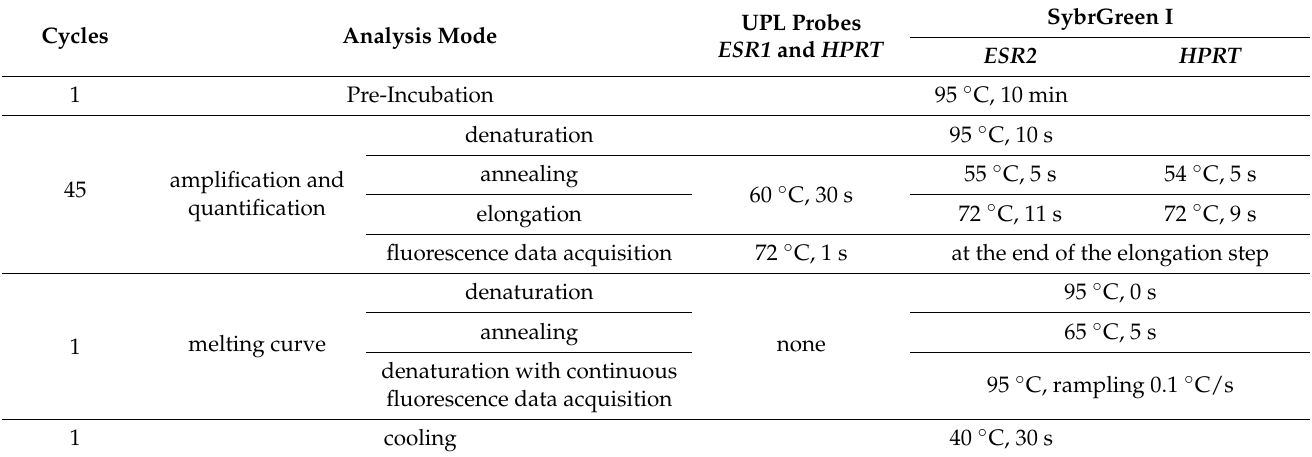
Table 3. Thermal profile for genes